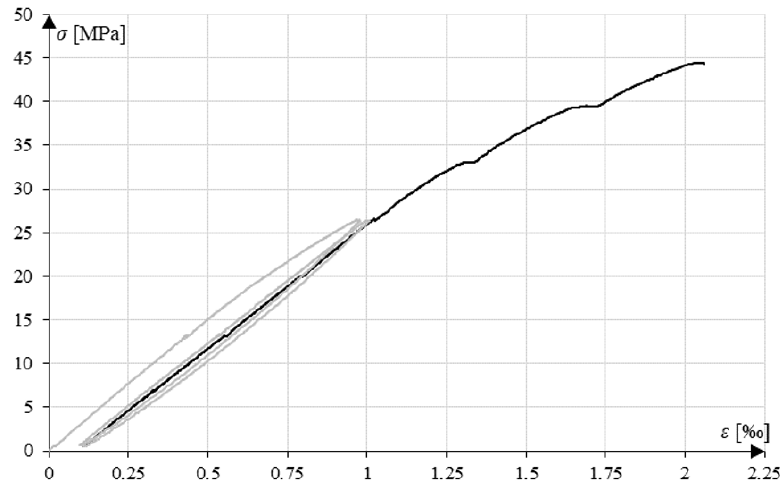
Figure 11: Stress–strain diagram for specimen tested according to method II.